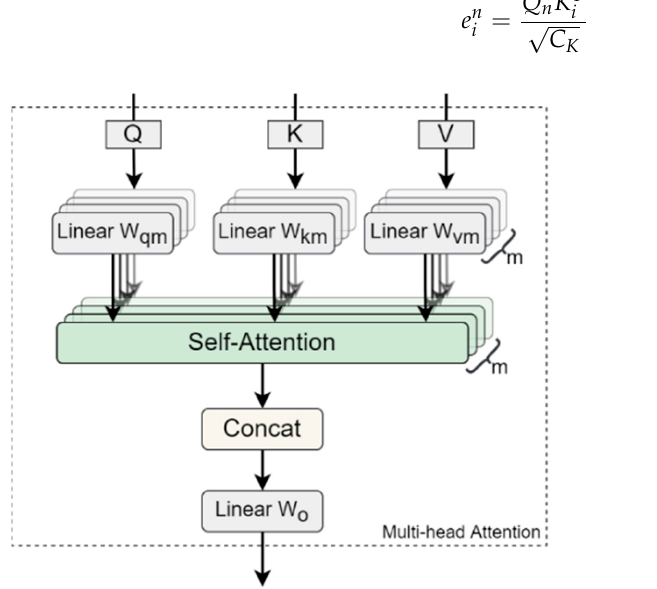
Figure 10. Structure of MHA.